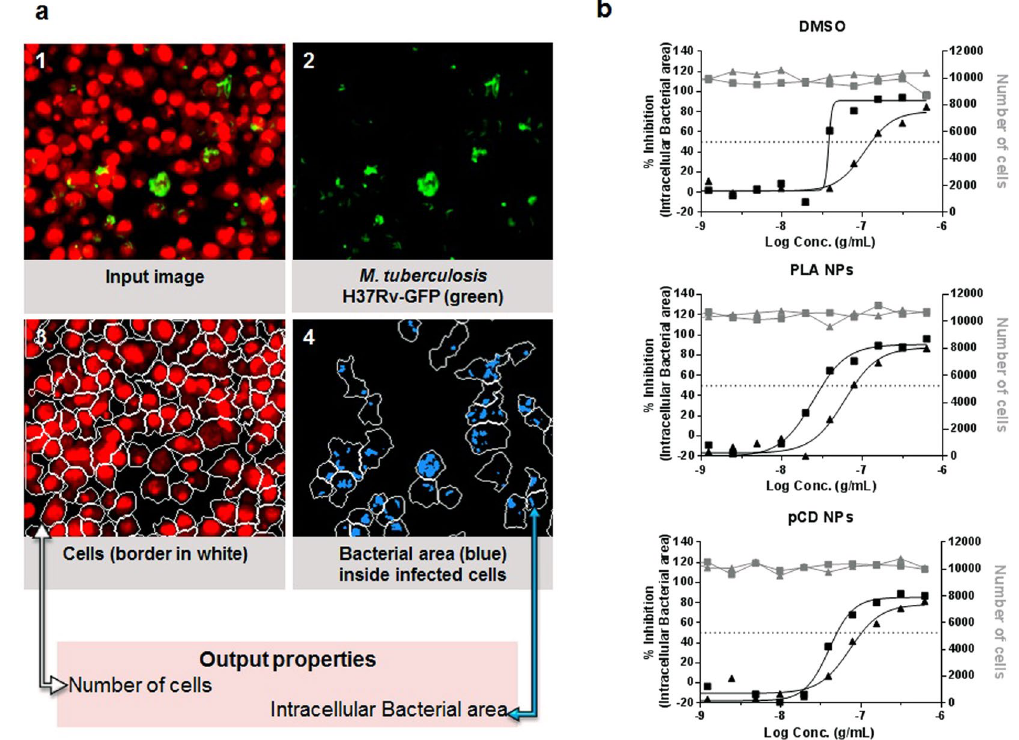
Figure 3. Intracellular antitubercular activity. ( a ) Scheme representing image-based analysis method performed with the image-analysis software Columbus 2.5.1 (PerkinElmer). 1 . Input image: cell nuclei and cell cytoplasm were stained with the DNA dye Syto60 and detected in the red channel; M . tuberculosis H37Rv-GFP was detected in the green channel. 2 . M . tuberculosis H37Rv-GFP detected in the green channel. 3 . Cells detection in the red channel. The estimated cell limit is represented in white. 4 . Bacterial area detected inside the cells area is represented in blue. Data related to the area of cells was detected in the red channel and data related to the bacterial area was detected in the green channel. ( b ) % of inhibition of intracellular bacterial area (black points) and number of cells (grey points) obtained with ETH (solid triangle) and [ETH:Booster] (solid square) in DMSO, PLA NPs and pCD NPs. Data presented corresponds to one representative experiment of three